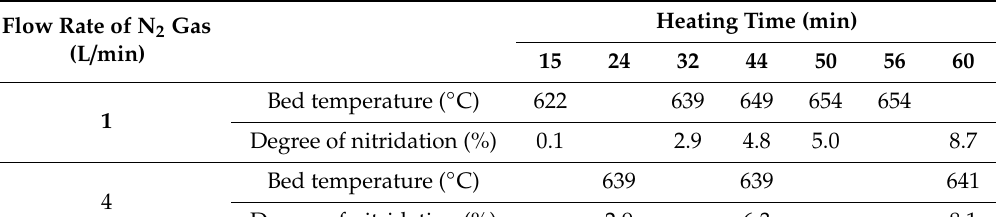
Table 1. The degrees of nitridation and temperatures of the powder bed with various nitrogen flow rates and heating times.